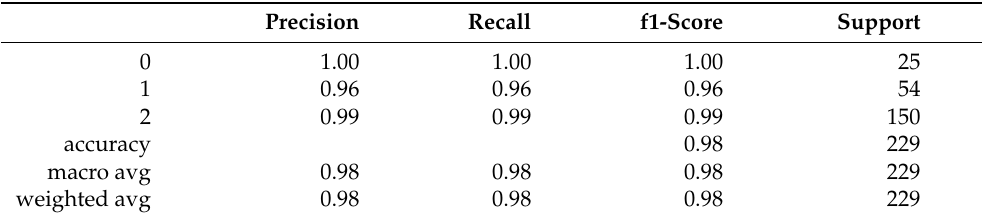
Table 11. Random forest metrics on test-set.